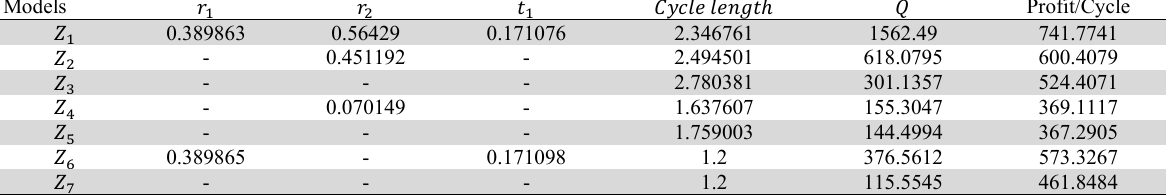
Optimal values of the decision variables for the models ignoring TVM and shortages (Example 2) Models